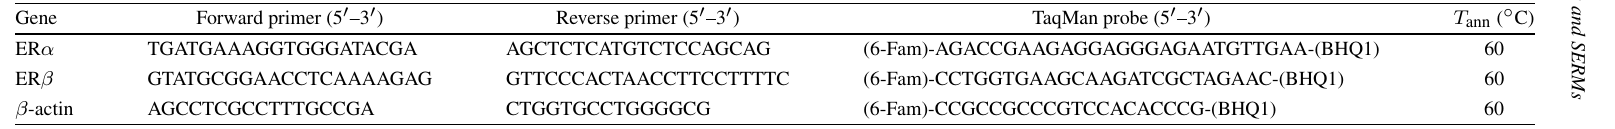
Sequences of primers and TaqMan probes used for quantitative analysis of gene